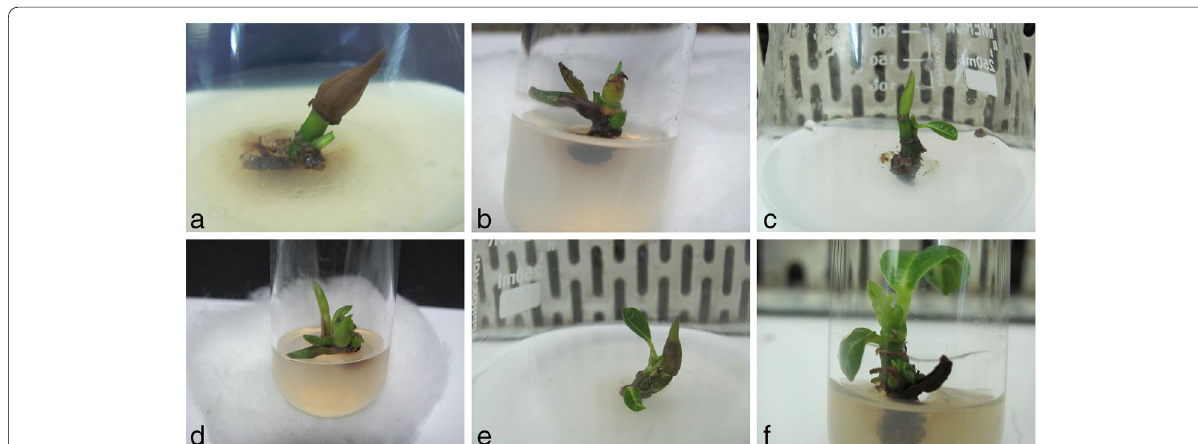
Fig. 1 In vitro clonal propagation of Artocarpus heterophyllus L. a Initiation of the breakdown of shoot tip on full-strength Murashige and Skoog (MS) medium supplemented with 6-benzylaminopurine (BAP) at the concentration of 1.5 mg L -1 , Indole-3-butyric acid (IBA) at 0.5 mg L -1 , and α-naphthaleneacetic acid (NAA) at 0.1 mg L -1 in combination after 3–4 days of inoculation. b Initiation of the shoot (shown with black arrows) on MS medium formulated with BAP at the concentration of 1.5 mg L -1 , IBA at 0.5 mg L -1 , and NAA at 0.1 mg L -1 in combination after 12 days of inoculation. c A shoot having a leaf on MS medium formulated with BAP at the concentration of 1.5 mg L -1 , IBA at 0.5 mg L -1 , and NAA at 0.1 mg L -1 in combination after 22 days of inoculation. d Initiation of shoots on MS medium formulated with BAP at the concentration of 0.5 mg L -1 and 6-furfuryl-amino purine (Kn) at the concentration of 1.5 mg L -1 after 8 days of culture. e Shoots having multiple leaves on MS medium formulated with BAP at the concentration of 0.5 mg L -1 and Kn at the concentration of 1.5 mg L -1 after 22 days of culture. f Enlargement of shoot and leaf after